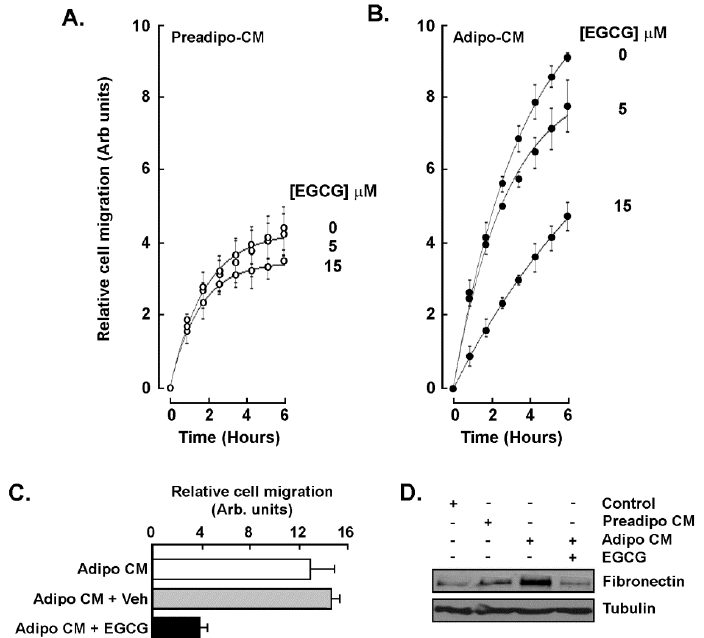
Figure 4. EGCG inhibits the acute response and prevents the paracrine regulation of TNBC